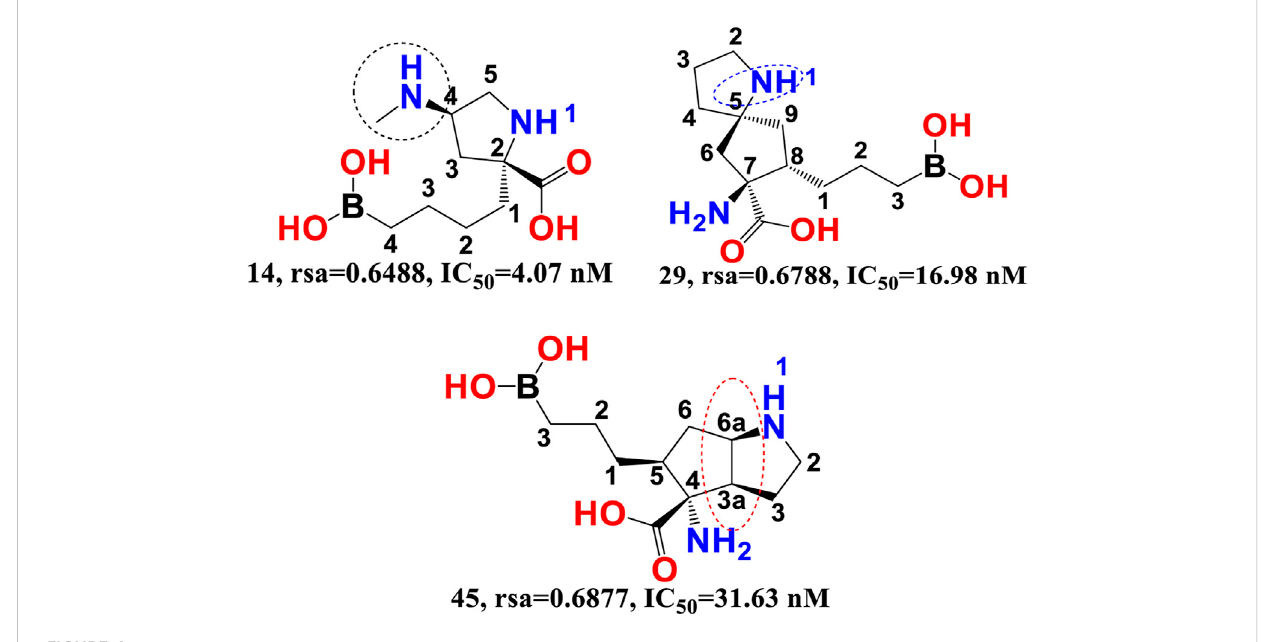
FIGURE 4 Illustration of the molecular descriptor rsa for the molecular pair 14, 29, and 45